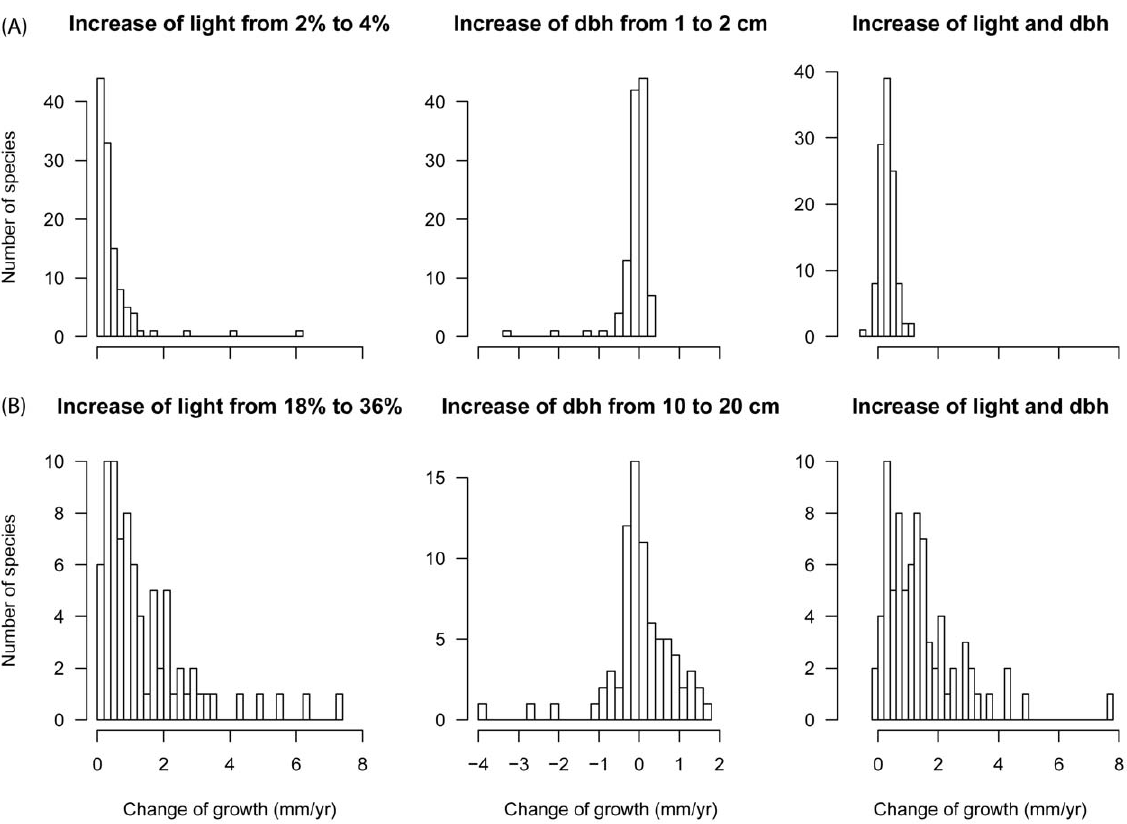
Figure 6. Impact of light availability and stem size on growth rates. Contributions of light availability and size to growth for species with $ 100 individuals. For small trees (A), contributions are expressed by the absolute difference between baseline growth rate of a tree at 1 cm dbh and average light (2%) and growth when light is doubled (4%), dbh is doubled (2 cm) or both. For larger trees (B), contributions are expressed by the difference between baseline growth of a tree at 10 cm dbh and average light (18%) and growth when light is doubled (36%), dbh is doubled (20 cm) or both.